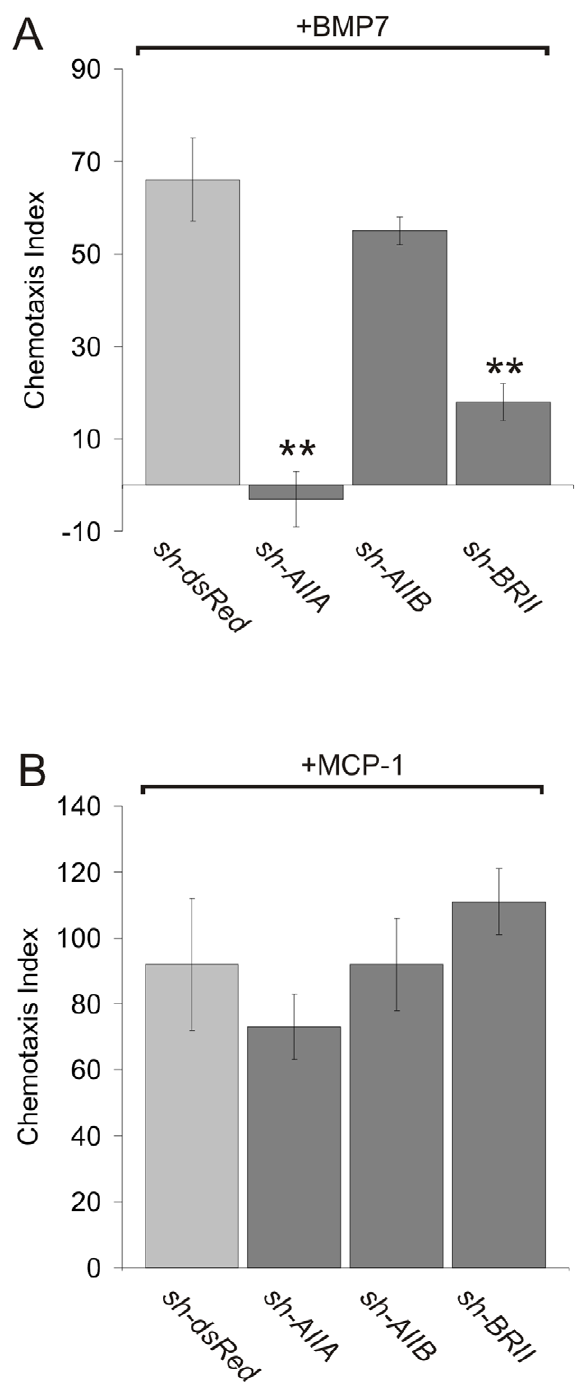
Figure 4. BMP7-stimulated WEHI 274.1 cell chemotaxis follow- ing type II BMP receptor knockdown. Chemotaxis of dsRed D 2 , ActRIIA D 2 , ActRIIB D 2 and BMPRII D WEHI cells (mean + / 2 SEM) in response to BMP7 (10 pg/ml, A) or MCP-1 (100 ng/ml, B). In A, dsRed D WEHI (CI=66 + / 2 9; n=8), ActRIIA D WEHI (CI= 2 3 + / 2 6; n=3), ActRIIB D WEHI (CI=55 + / 2 3; n=4) and BMPRII D WEHI cells (CI=18 + / 2 4; n=7). n=3 for each condition in B. BMP7-stimulated chemotaxis following knockdown with either sh-AIIA or sh-BRII differs significantly from that in dsRed D WEHI (control) cells; (**) p , 0.0001 (Student’s t test).